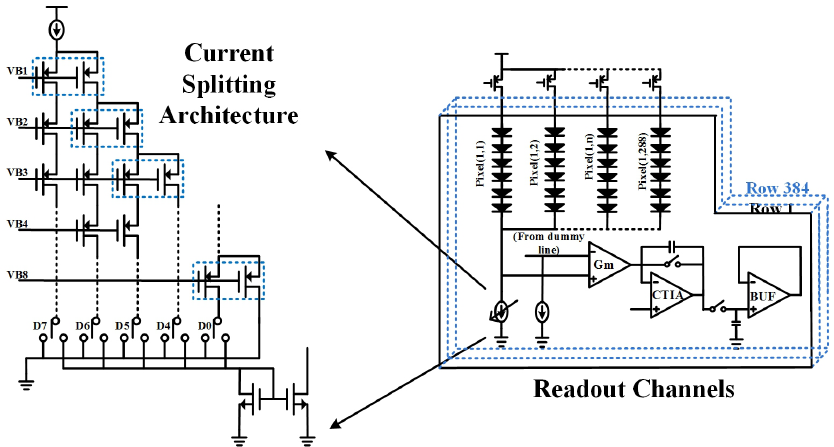
Figure 2. Proposed current splitting architecture-based variable current source.